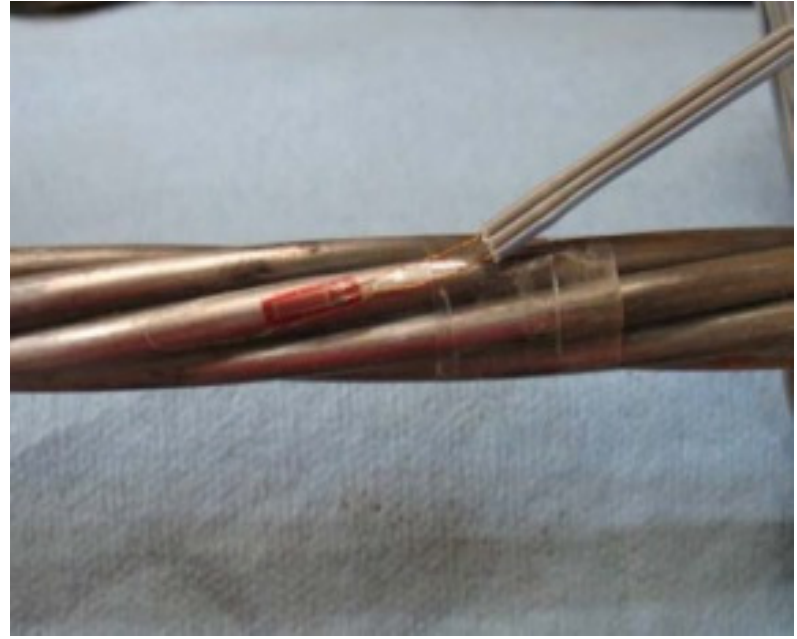
Figure 10. Strain gauge on the post-tensioning strand